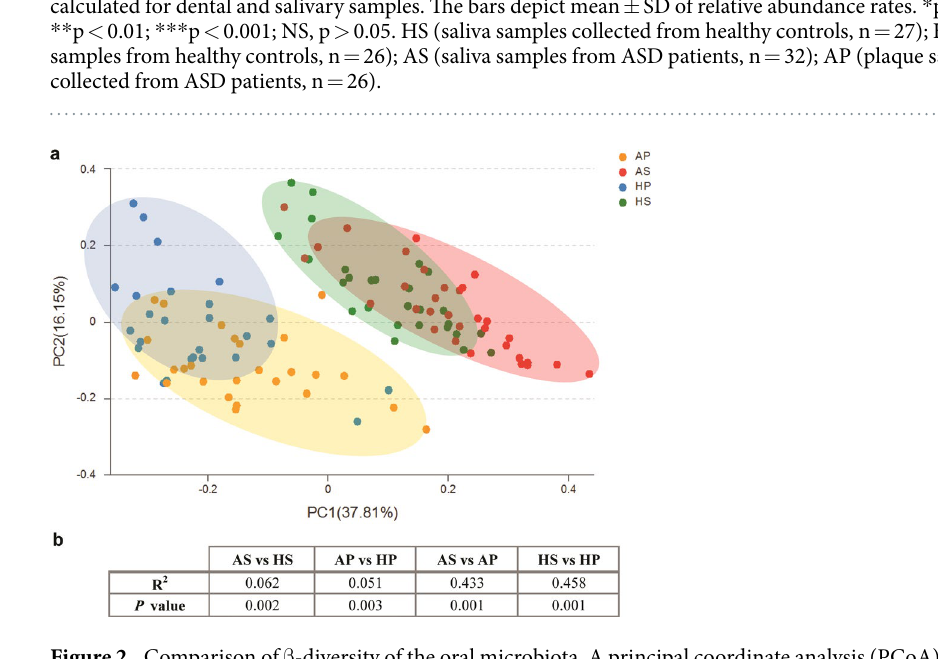
Figure 2. Comparison of β -diversity of the oral microbiota. A principal coordinate analysis (PCoA) score plot for all samples (principal coordinates 1 and 2) based on weighted UniFrac distance was generated to depict the divergence in distribution of the oral microbiota ( a ). Each point represents the oral microbiota composition of one sample. PERMANOVA shows statistically significant community differences between ASD and healthy controls within each habitat, as well as between saliva and dental plaques, regardless of the disease status ( b